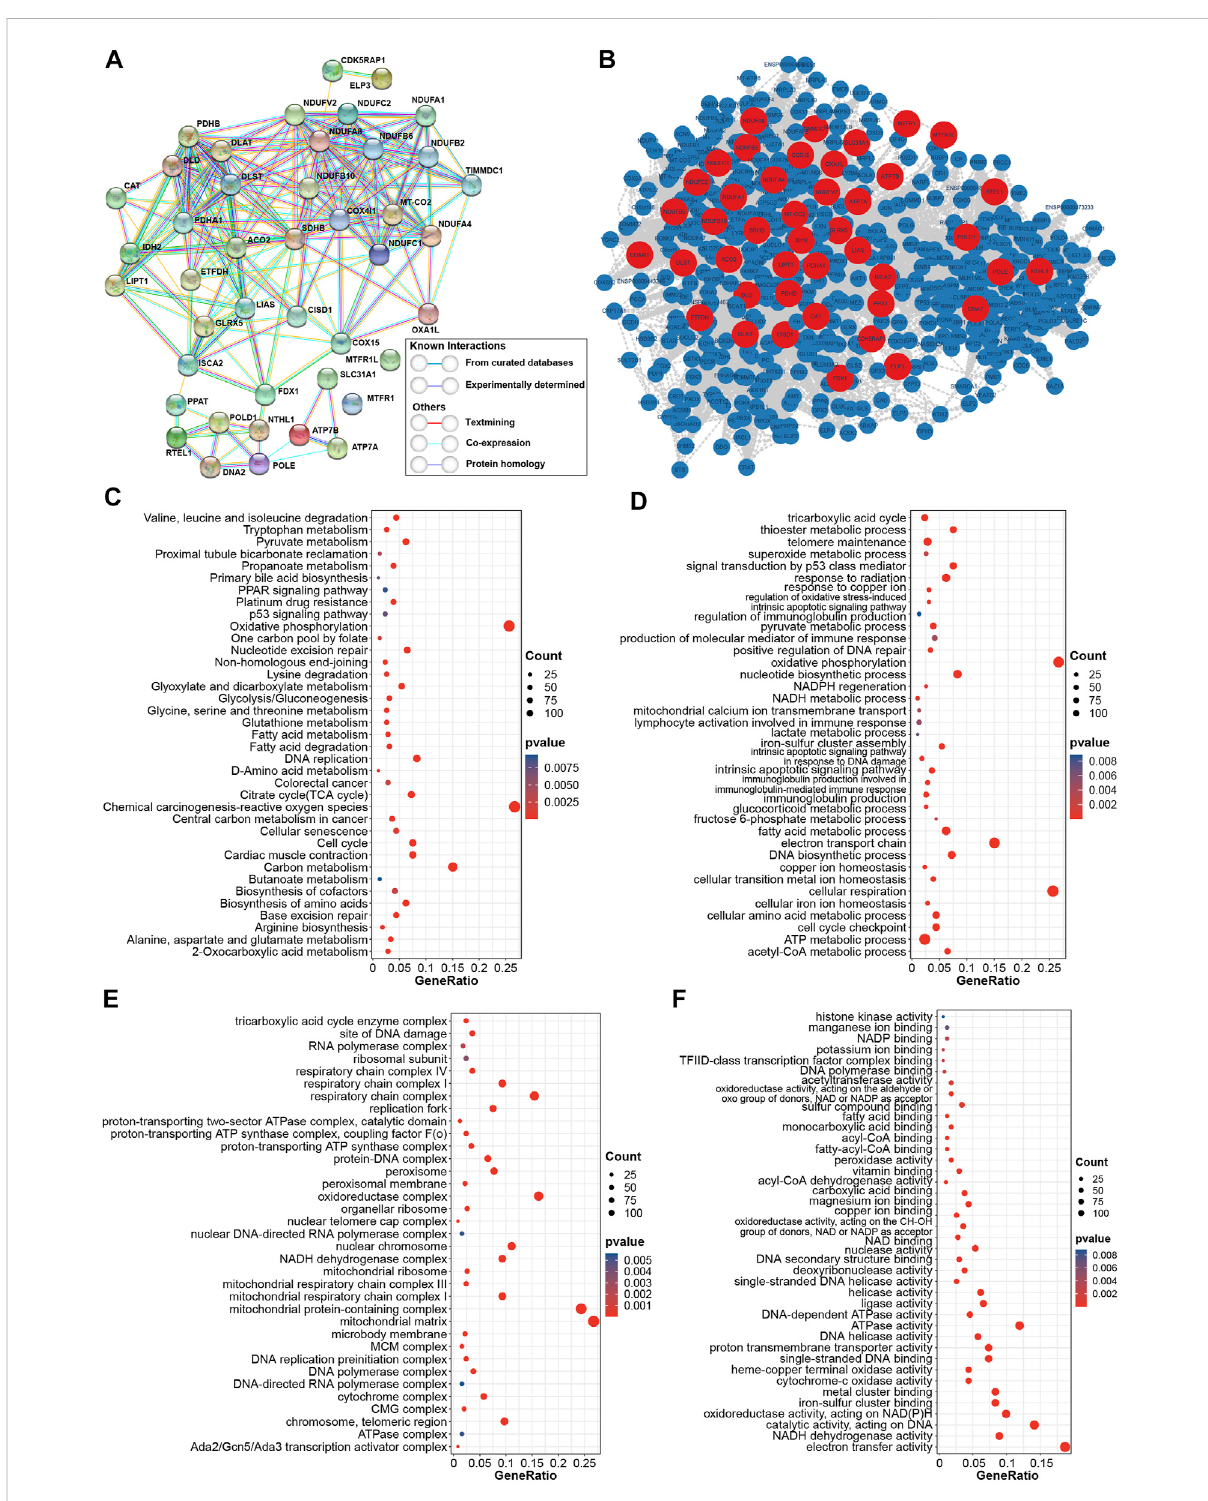
FIGURE 3 Construction of PPIs network and functional enrichment analysis (A) Internal PPIs network of CRGs obtained from STRING database (B) PPIs network of 522 CRPs from the STRING database, red: proteins coded by CRGs; blue: additional proteins obtained from the STRING database (C) KEGG enrichment analysis of CRPs (D) Enrichment analysis for CRPs based on GO biological process terms (E) Enrichment analysis for CRPs based on GO cellular component terms (F) Enrichment analysis for CRPs based on GO biological function